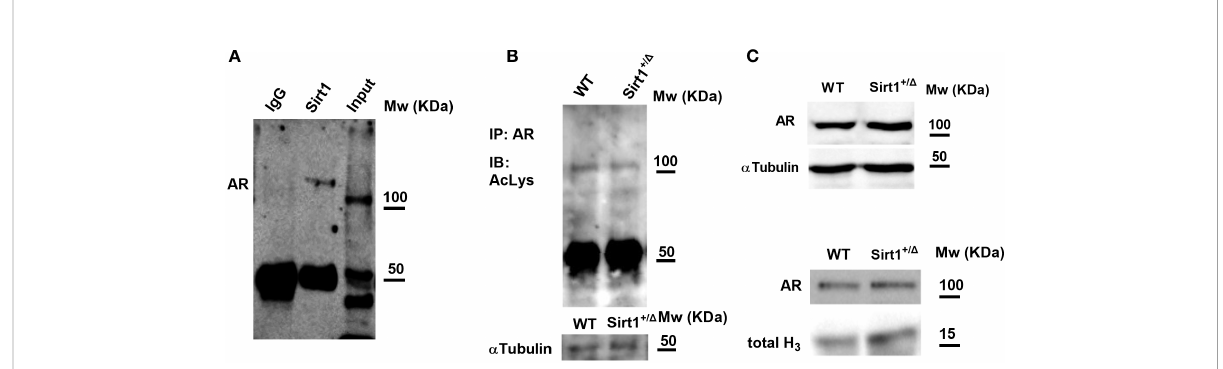
FIGURE 7 SIRT1 and the androgen receptor (AR). (A) SIRT1 associates with AR in Sirt1 -over expressing C3HT101/2 cells; immunoprecipitation (IP) with anti SIRT1 and IgG (negative control) antibodies. (B) AR acetylation in bone marrow fl ush in 9-week-old Sirt1 +/ D and WT male mice. IP with anti SIRT1 antibody, immunoblot with anti-acetylated lysine antibody. (C, D) . AR in bone marrow fl ush in 9-week-old Sirt1 +/ D and WT male mice; C- Cytosolic fraction with a -tubulin as control. D-Nuclear fraction with Histone 3 (H3) as control (a pool of 3